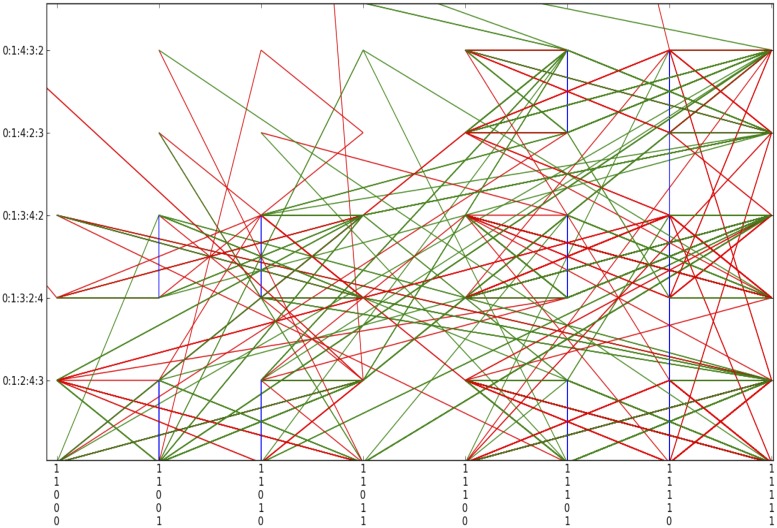
Orbits in SA rich population that cluster in the region R
HH ≥ 40, HS ≥ 3 where both household head and household size are favourably constant.This is the zoomed region in Fig 4(a) with high percentage of household visit.